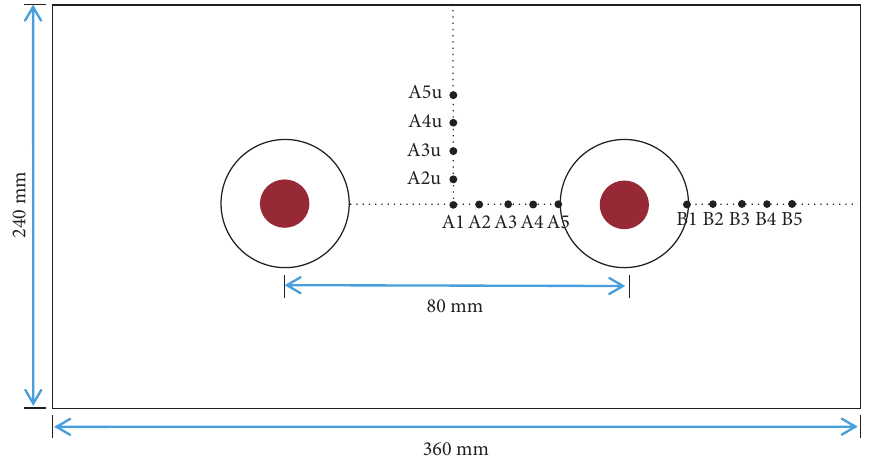
Figure 5: Schematic diagram of numerical